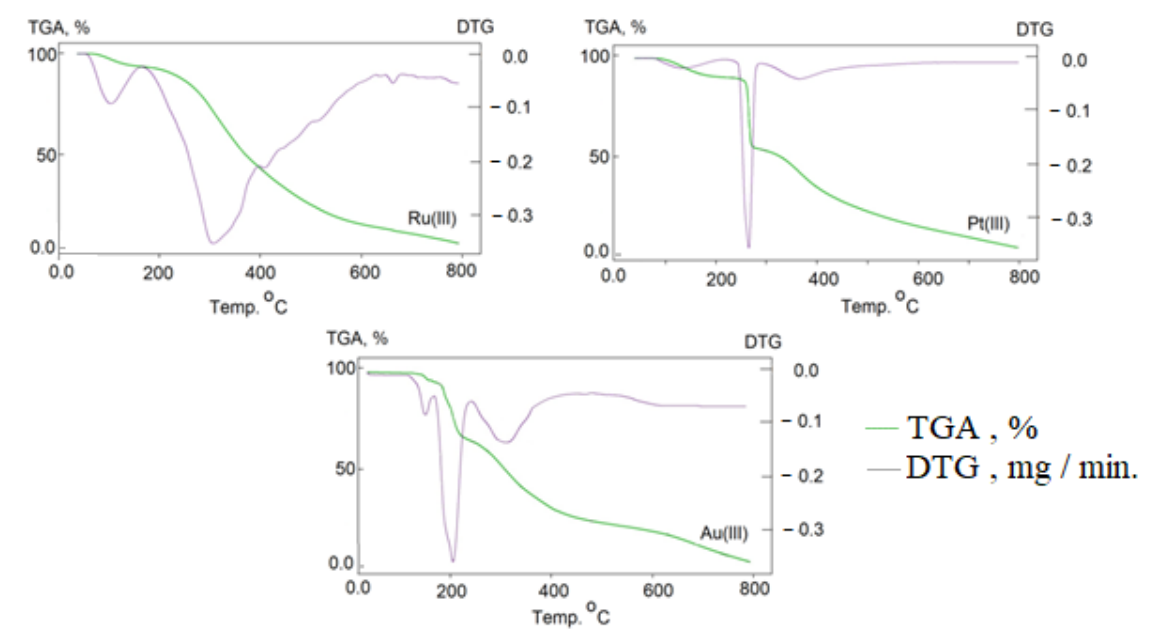
Figure 3. TGA and DTG diagram for Pt(IV), Au(III) and Ru(III) complexes. Table 6. The extreme temperature T max ( ◦ C) and weight deficiency data of the decomposition stages for sulfamethoxazole, Pt(IV), RU(III)and Au(III) complexes.